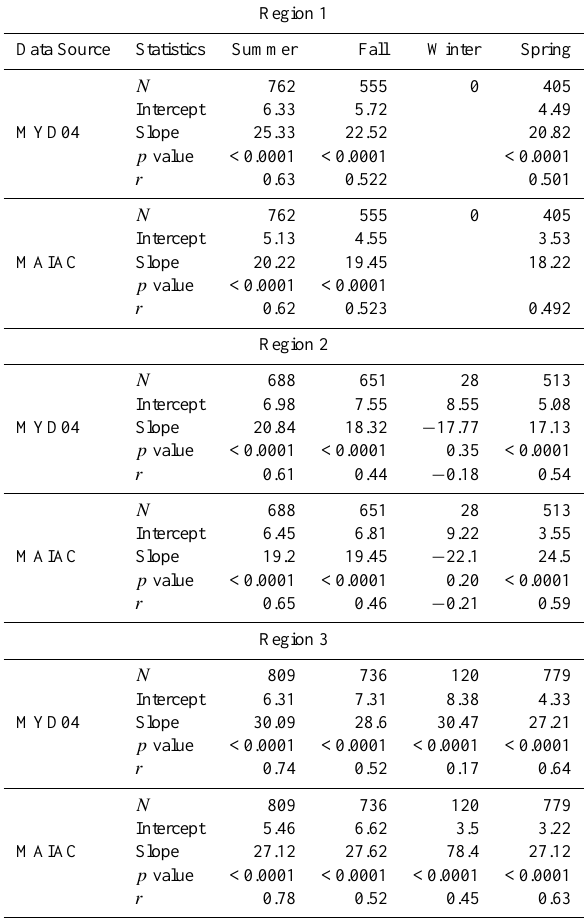
Table 2. Seasonal comparison between coarse MYD04 AOD 10km and fine-resolution MAIAC 1km AOD for the same days and loca- tions.